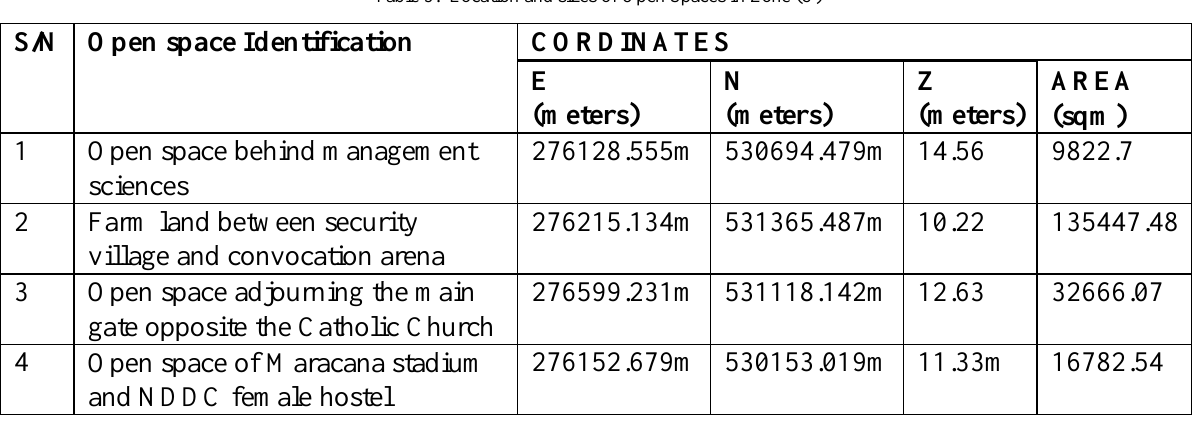
Table 3: Location and sizes of Open Spaces in Zone (C)